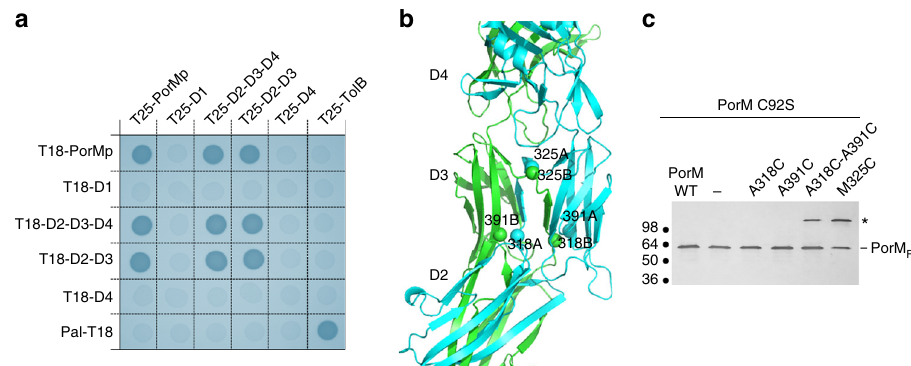
Fig. 4 In vivo validation of the PorMp structure. a Bacterial two-hybrid analysis. BTH101 reporter cells carrying pairs of plasmids producing the indicated PorM fragments fused to the T18 or T25 domain of the Bordetella adenylate cyclase were spotted on X-Gal-IPTG reporter LB agar plates. The blue coloration of the colony reports interaction between the two partners. Controls include T18 and T25 fusions to TolB and Pal, two proteins that interact but unrelated to the T9SS. b Ribbon representation of a portion of PorM with the Cys mutants (tested in c ) identi fi ed by spheres. c Disul fi de-bond formation. Total membrane fractions from cells producing the wild-type (WT) FLAG-tagged PorM protein, and the indicated cysteine variants introduced into the cysteine-less C92S PorM, were subjected to 10%-acrylamide SDS-PAGE and immunodetected using the anti-FLAG antibody. The asterisk on right indicates bands corresponding to a PorM dimer. Molecular weight markers are shown on right